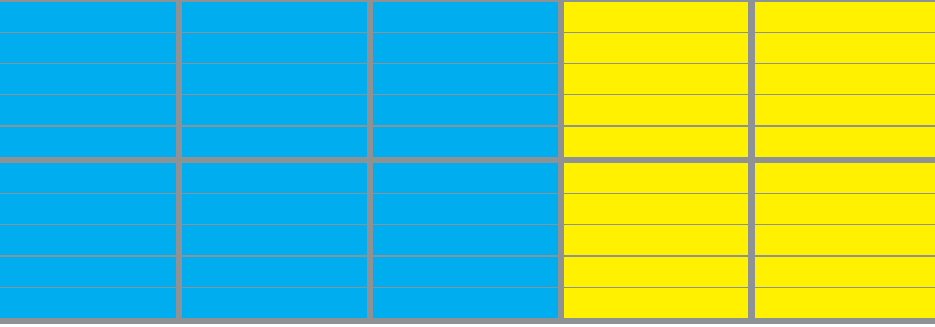
Fifty voting precincts are to be apportioned into ten contiguous districts. Each precinct is dominated by either the Cyan or the Yellow party and each precinct has approximately the same voting population. In this plan, the percentage of Cyan (Yellow) districts equals the percentage of Cyan (Yellow) precincts. No partisan bias is evident in the plan. All districts are homogeneous by